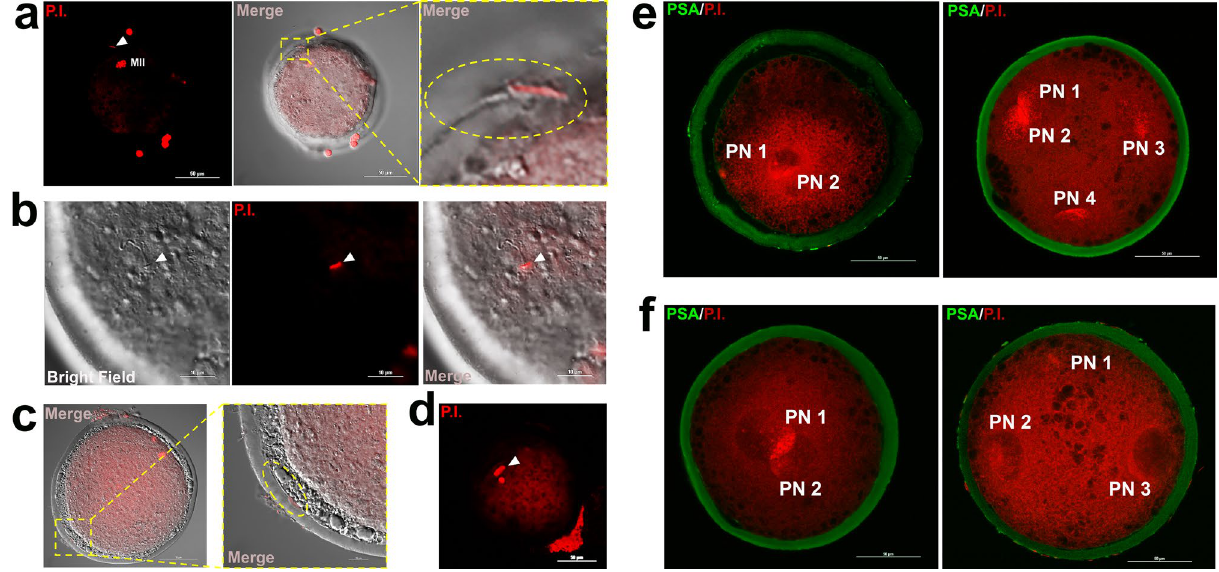
Figure 2. Controlled time-IVF. ( a ) spermatozoon is passing through the zona pellucida (arrow head) 90 min post the beginning of IVF. ( b ) a spermatozoon (arrow head) position at 120 min post IVF. ( c ) Spermatozoon (arrow head) at the perivitelline space at 180 min post-IVF. ( d ) early sperm nucleus decondensation at 240 min after-IVF. ( e , f ) Pronuclear evaluation at 14 h post-IVF. ( e ) o/nIVF embryos, on the left normal 2 Pronuclear (2PN) fertilization, on the right polyspermic fertilization (> 2PN). ( f ) shIVF group, on the left normal 2 Pronuclear (2PN) fertilization, on the right polyspermic fertilization (> 2PN). Red signal: Propidium Iodide (P.I.); green signal: Pisum Sativum Agglutinin (PSA). Scale bar in ( a , d , e , f ): 50 μm. Scale bar in ( b , c right): 10 μm. Sperm-eggs time coincubation